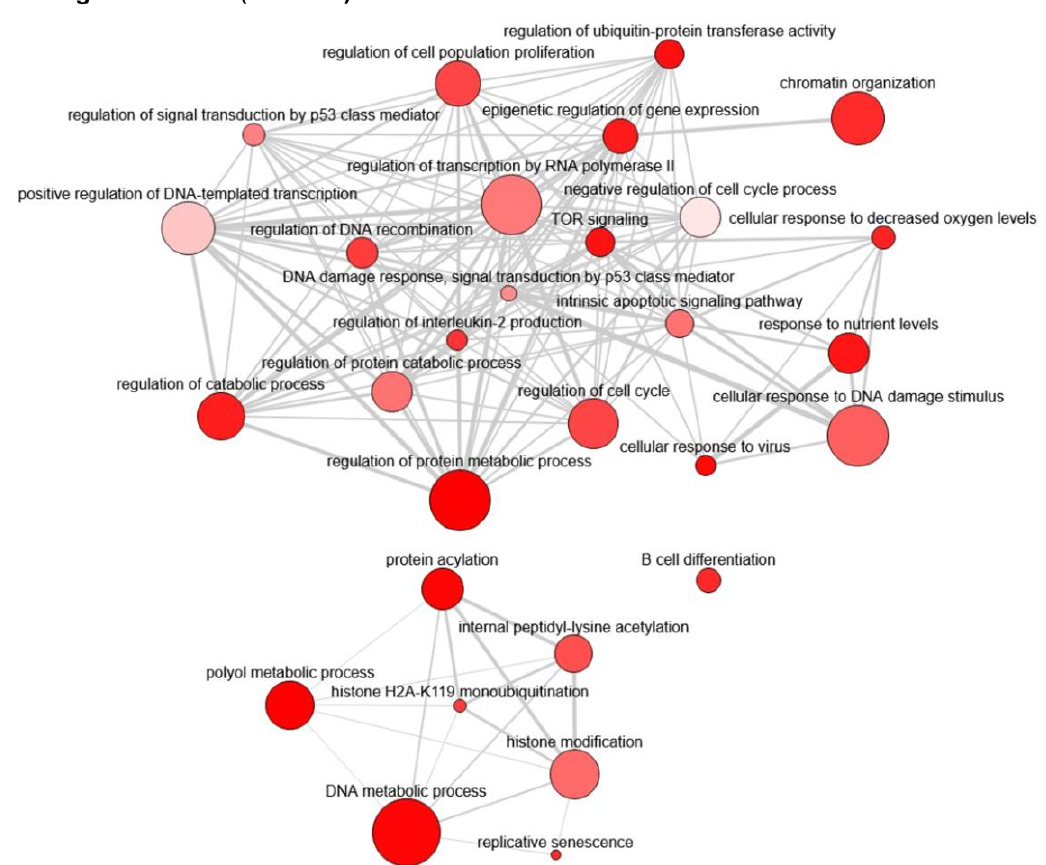
Figure 3. Common biological functions among the critical genes from Figure 2 for E µ -Myc lymphomas were analyzed using Enrichr and the corresponding GO (gene ontology) terms [66,67]. Visualization was performed using the Revigo tool [68]. The color of the bubble corresponds to the adjusted p value (the redder, the lower the p value) and the size to the genes under the GO